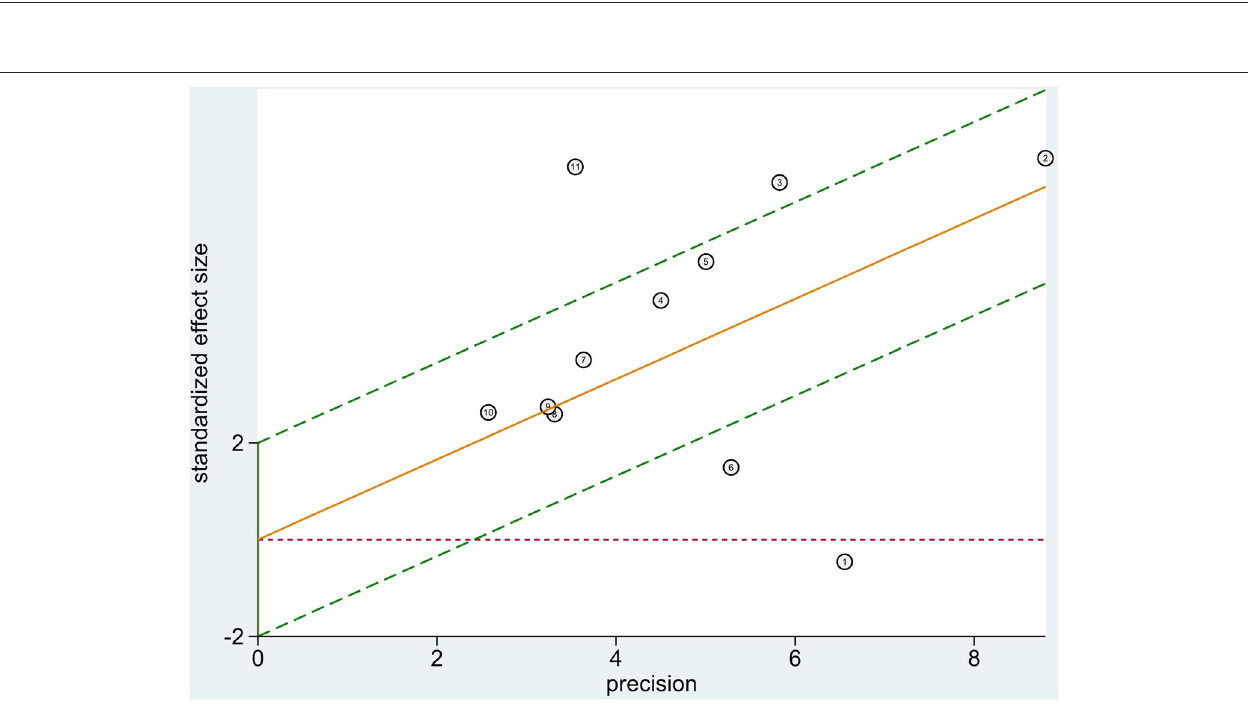
Frontiers in Cardiovascular Medicine |